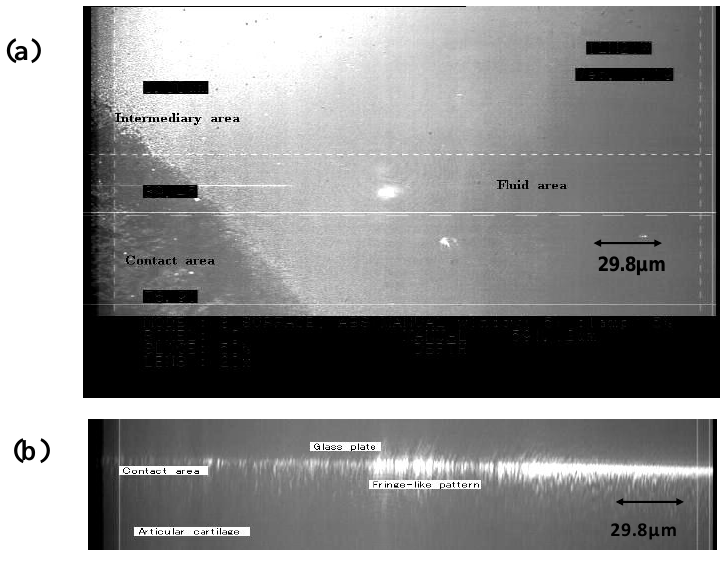
Figure 9. CLSM image of normal articular cartilage surface of rabbit knee joint under loading. (a) CLSM image of articular cartilage surface through glass plate (×1,000). (b) Cross-section view of CLSM image (×1,000).